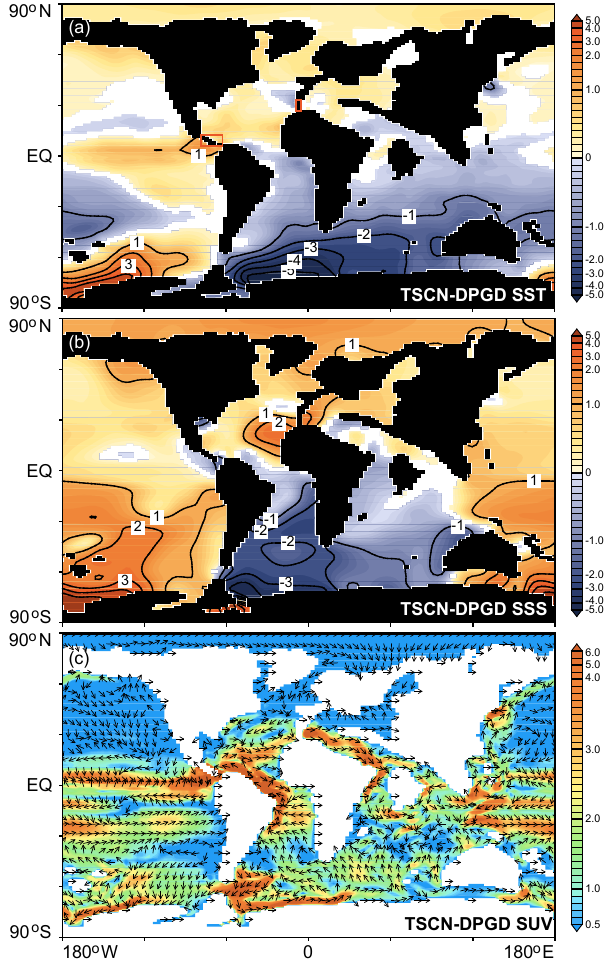
Figure 4. Geographic changes of (a) SST ( o C) , (b) SSS and (c) surface currents at 50m (cm/s) between the TSCN and the DPGD experiment. SST and SSS changes with confidence levels greater than 95% are illustrated in (a) and (b). The two red rectangles in (a) highlight the Central American Seaway (Left) and the section of the Tethys Seaway (Right) for calculating water mass in Table 2.